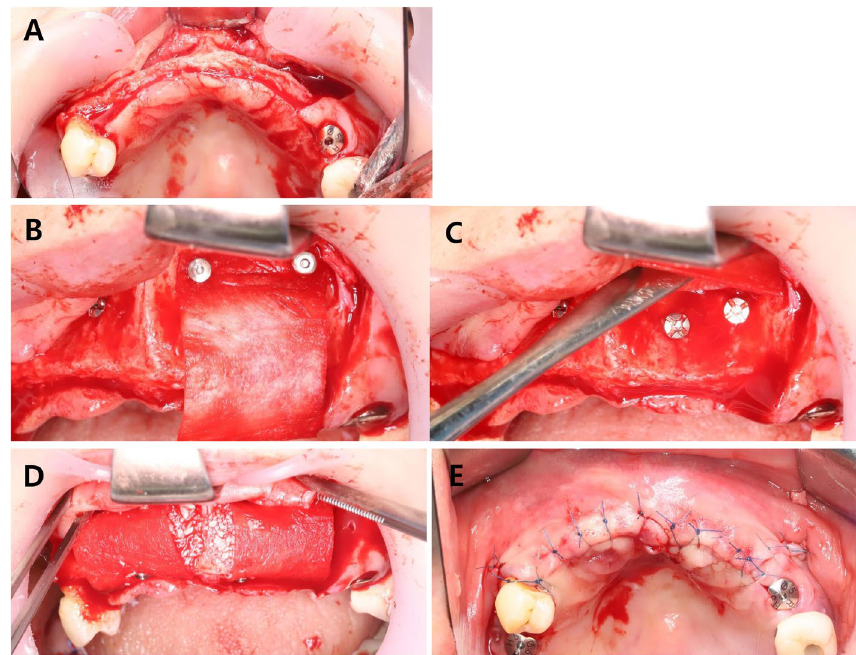
Fig. 1 Horizontal bone augmentation using sausage technique in maxillary anterior zone. A Incision and flap reflection. B and C Bone tack and bone screw insertion. D and E Bone graft and primary closure were done